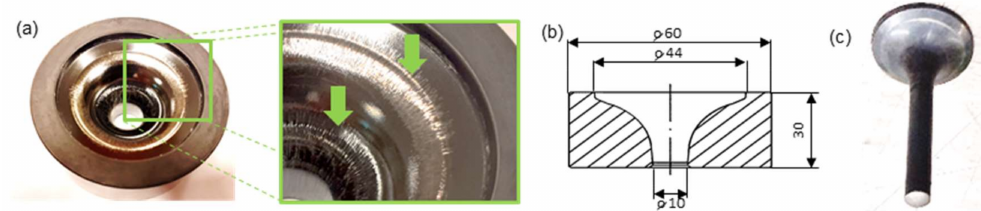
Figure 3. A selected, exemplary forging tool for the analyzed die forging process ( a ) removed from the production process, with visible wear for a die insert used in roughing, ( b ) key geometrical dimensions, ( c ) photograph of an exhaustion valve forging assigned for motor truck